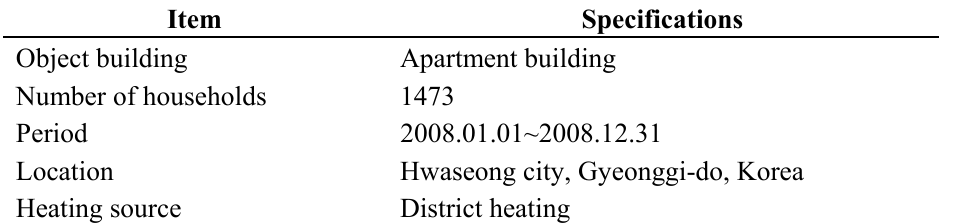
Table 1. Specifications of model group energy apartment for optimal heat supply